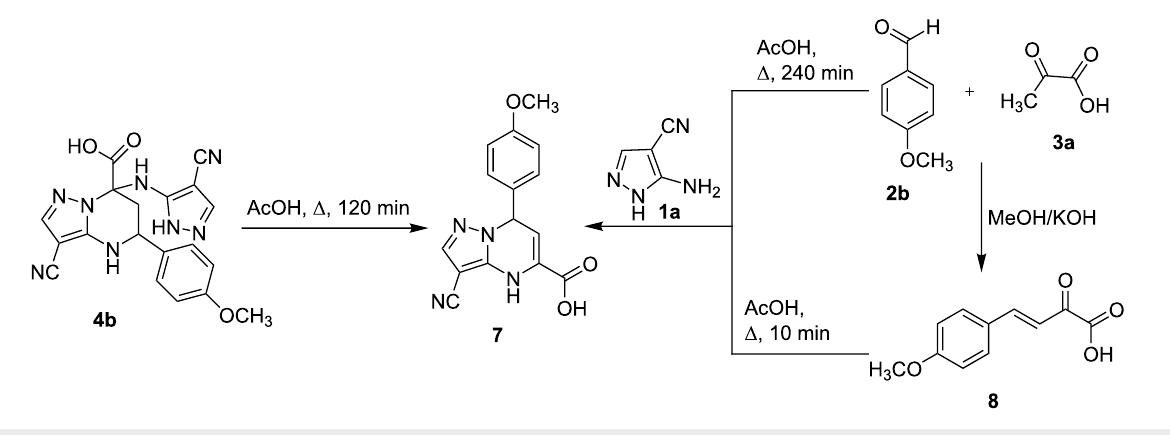
Scheme 5: Synthesis of 3-cyano-7-(4-methoxyphenyl)-4,7-dihydropyrazolo[1,5- a ]pyrimidine-5-carboxylic acid ( 7